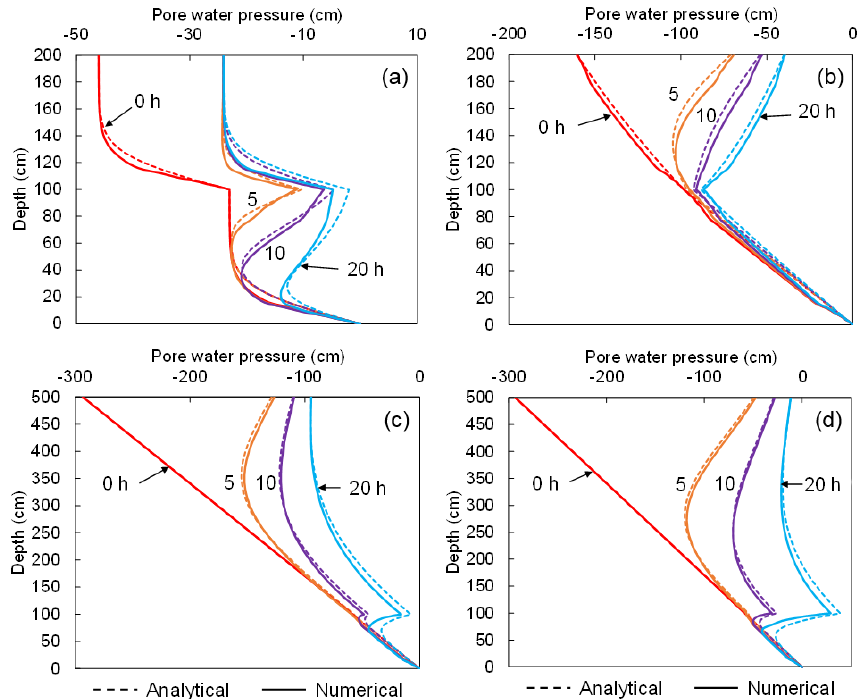
Figure 8. Pore water pressure profiles at various times: (a) case 1; (b) case 2; (c) case 3; and (d) case 4.